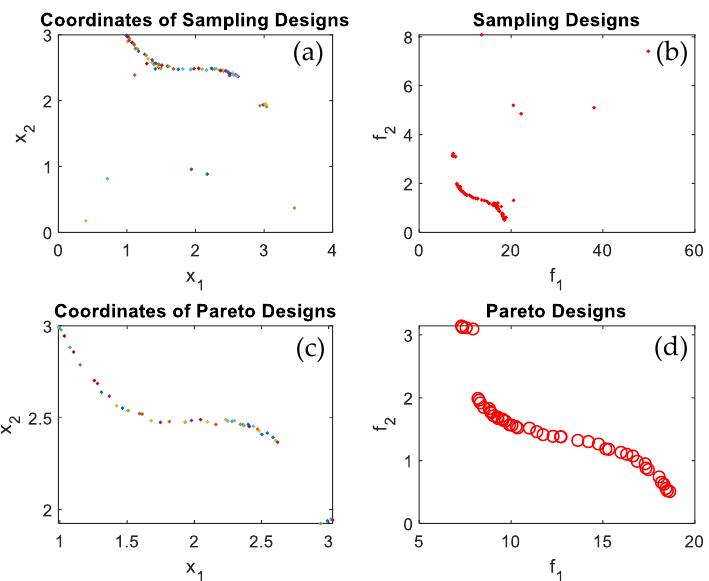
Figure 7. Computational simulations Pareto frontier determination of test function T2 ( a ) coordinates od sampling points; ( b ) sampling points in feasible design space; ( c ) coordinates of Pareto points; ( d ) the seeking Pareto frontier.